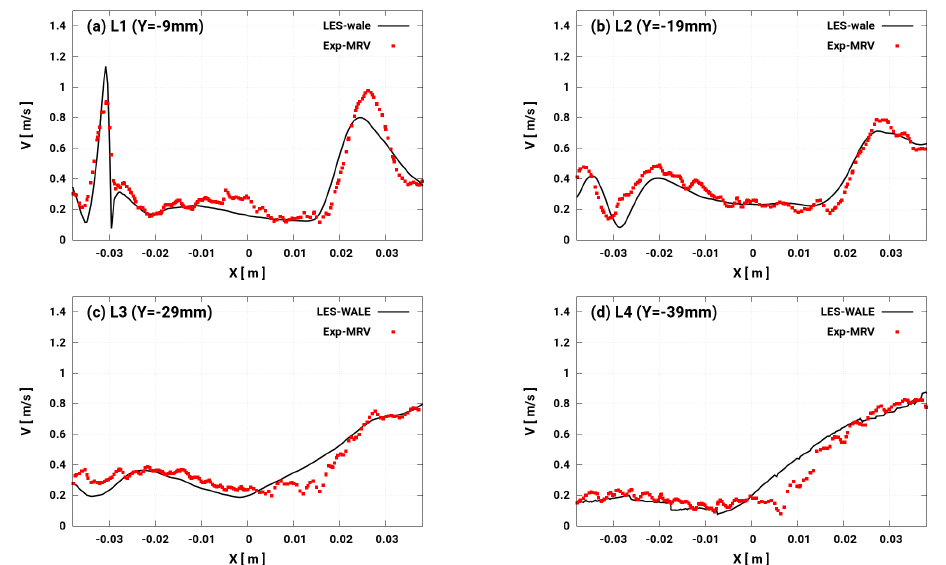
Figure 12. Comparison of velocity profile for LES and MRV at various locations (see Figure 11) on plane at Z = − 19